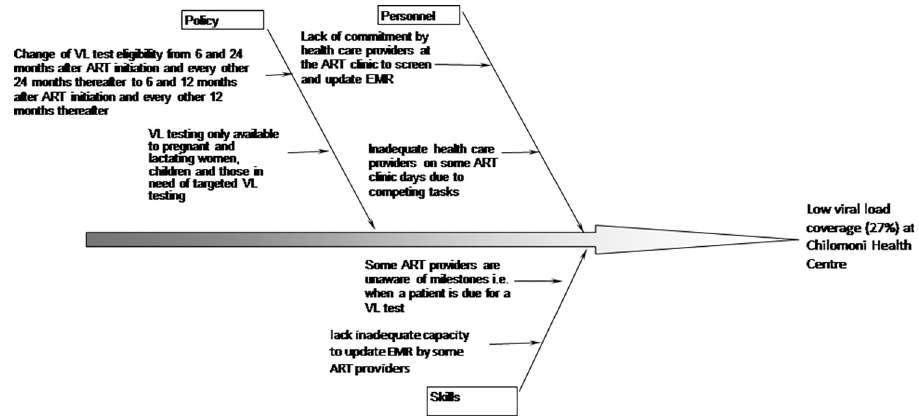
Fig 1. Fishbone diagram of root causes of low VL testing coverage at Chilomoni health centre, Blantyre.